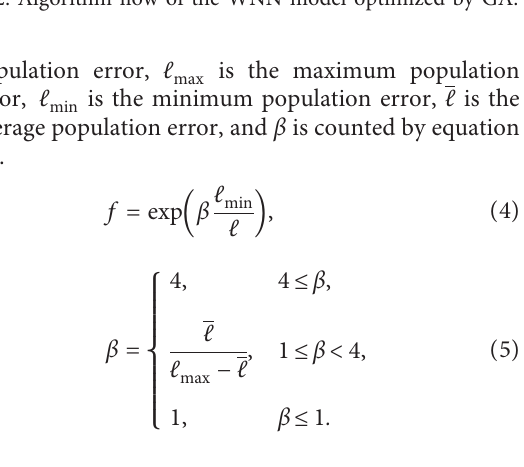
Figure 2: Algorithm flow of the WNN model optimized by GA.